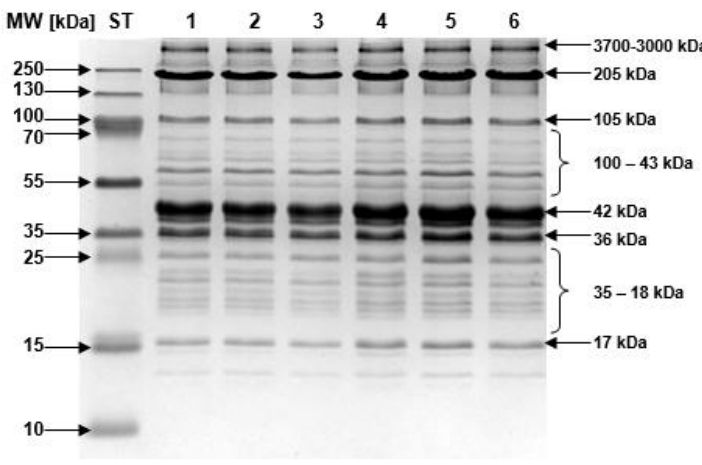
Figure 2. Comparison of distributions of muscle fiber protein types in longissimus lumborum: 1, 3, 5—control groups (C, E1, and E2, respectively); 2, 4, 6 experimental groups (C + EM, E1 + EM, and E2 + EM, respectively).